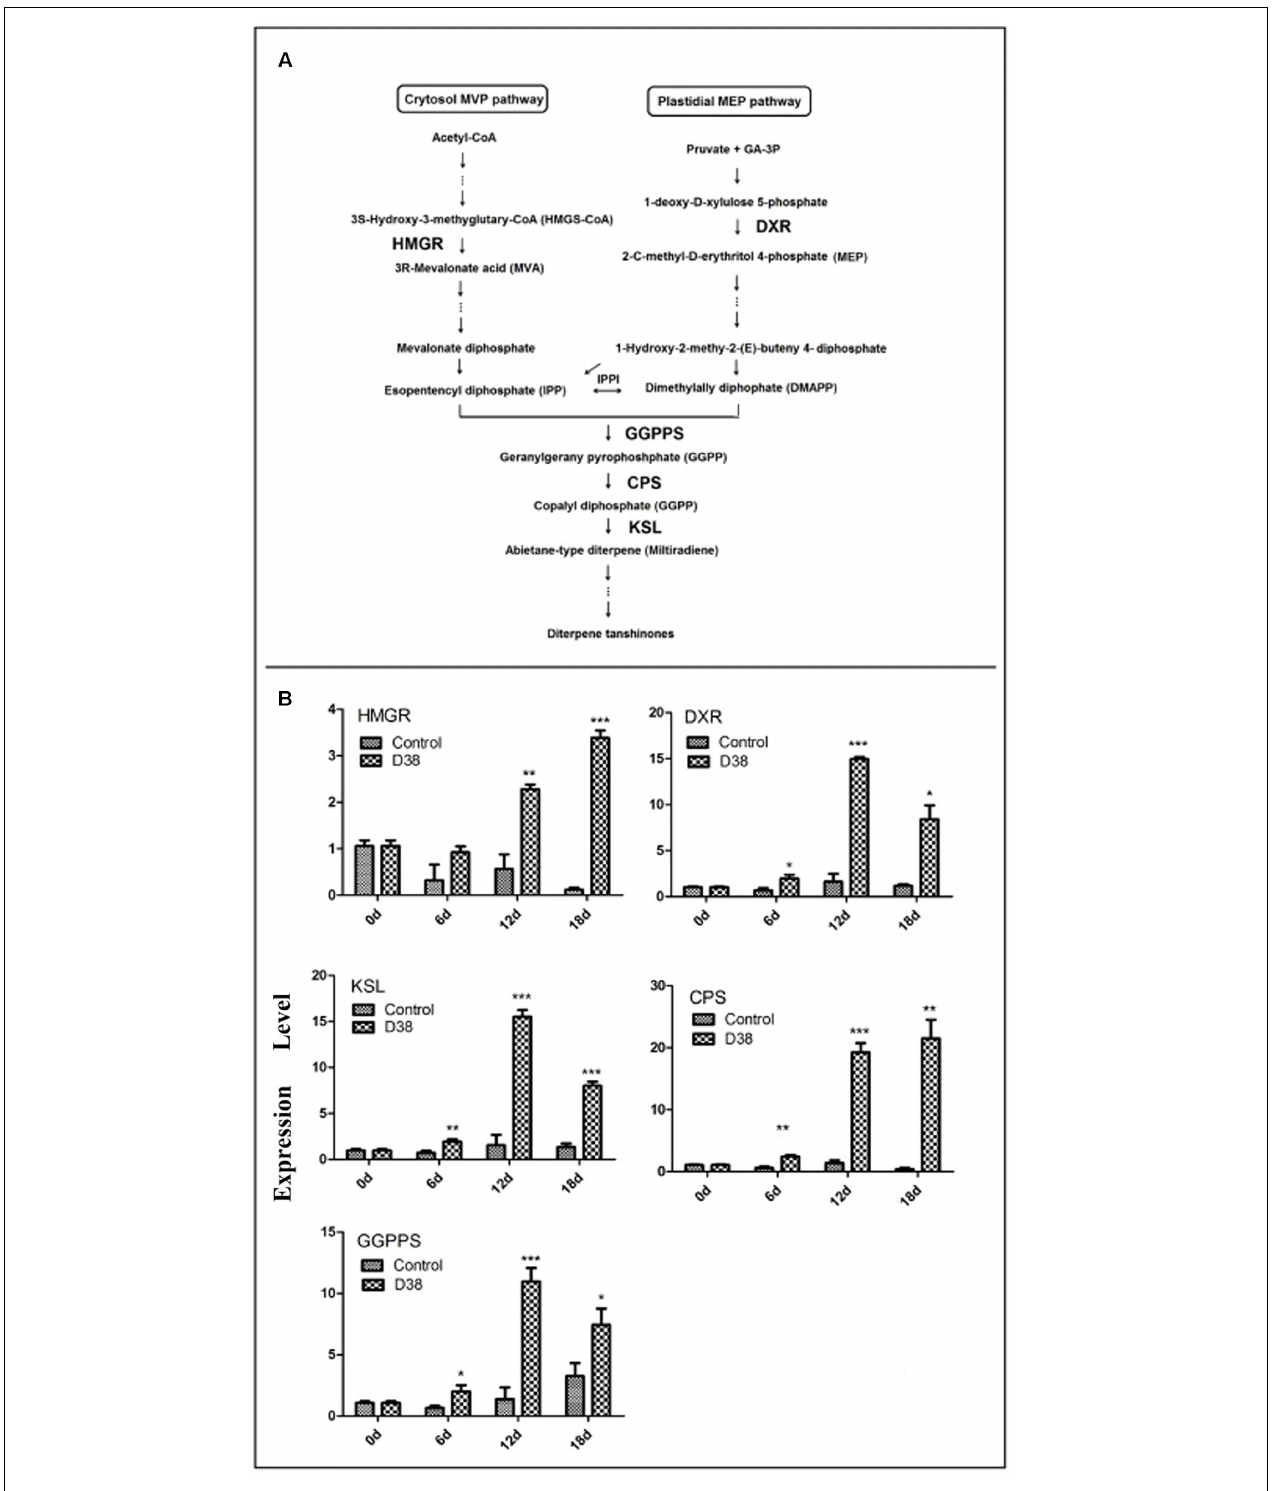
FIGURE 6 | Proposed pathways of tanshinone biosynthesis in S. miltiorrhiza (A) and effects of D38 EM (100 mg · l − 1 ) on the expression of genes in tanshinone biosynthetic pathway in S. miltiorrhiza hairy roots (B) . HMGR, hydroxymethylglutaryl-CoA reductase; DXR, 1-deoxy-d-xylulose 5-phosphate reductoisomerase; GGPPS, geranylgeranyl diphosphate synthase; CPS, copalyl diphosphate synthase; KSL, kaurene synthase-like. Values are presented as means ± SD, n = 3. ∗ p < 0.05; ∗∗ p < 0.01; ∗∗∗ p < 0.001 versus the control culture.